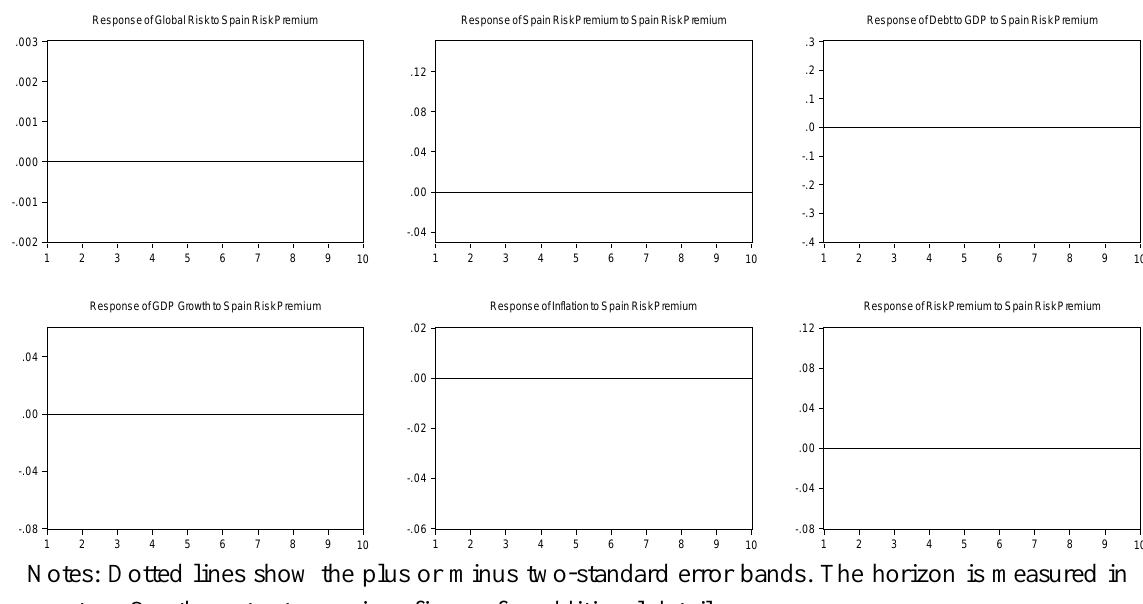
Figure 5. Pre-crisis response of EMU countries to a shock to Spain’s risk premium: